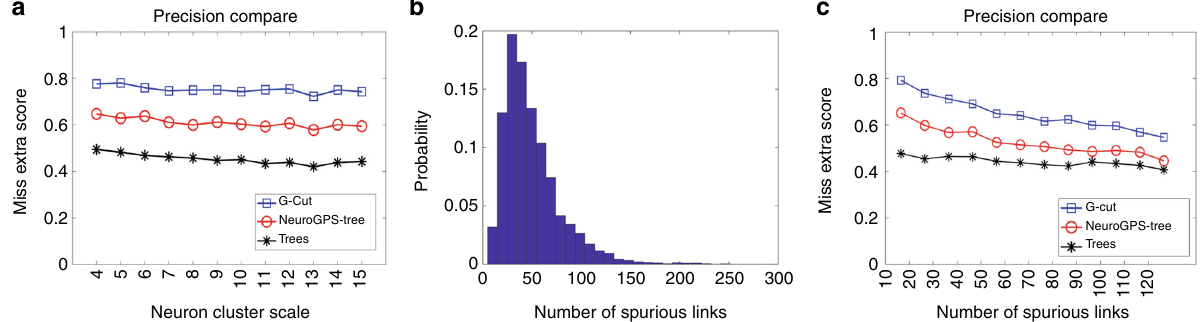
Fig. 5 Evaluating the segmentation accuracy of G-Cut on simulated neuron clusters. a Segmentation accuracy of G-Cut compared to NeuroGPS-tree and TREES toolbox on different scales of simulated neuron clusters (sample size: 100 neuron clusters for each scale). Mann – Whitney U tests with Benjamini- Hochberg correction show that G-Cut has consistently higher accuracy ( p < 0.01) across all scales of clusters. b The probability distribution of degree of entanglement in randomly generated neuron clusters with a fi xed cluster scale of six. c Segmentation accuracy of G-Cut compared to NeuroGPS-Tree and TREES toolbox on simulated neuron clusters with different degrees of entanglement (sample size: 100 neuron clusters for each degree of entanglement). The MES result of G-Cut is consistently higher than both NeuroGPS-TREE and TREES toolbox at all degrees of entanglement ( p < 0.01, Mann – Whitney U test with Benjamini-Hochberg correction). Source data are provided as a Source Data fi